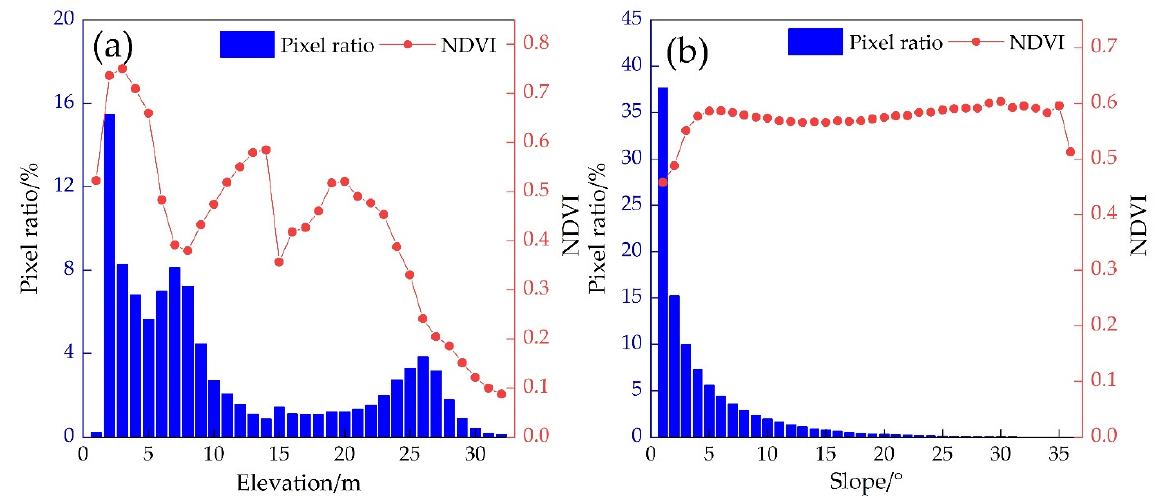
Figure 8. ( a ) Relationship between NDVI and elevation in China (1 ‒ 31 represent elevation zones of − 200 ‒ 0 m, 0 ‒ 200 m, 200 ‒ 400 m, …, 5800 ‒ 6000 m, respectively; 32 indicates that the elevation is > 6000 m); and ( b ) relationship between NDVI and slope in China (1 ‒ 35 represent the slope zones 0° ‒ 1°, 1° ‒ 2°, 2° ‒ 3°, …, 34° ‒ 35°, respectively; 36 denotes a slope > 35°).